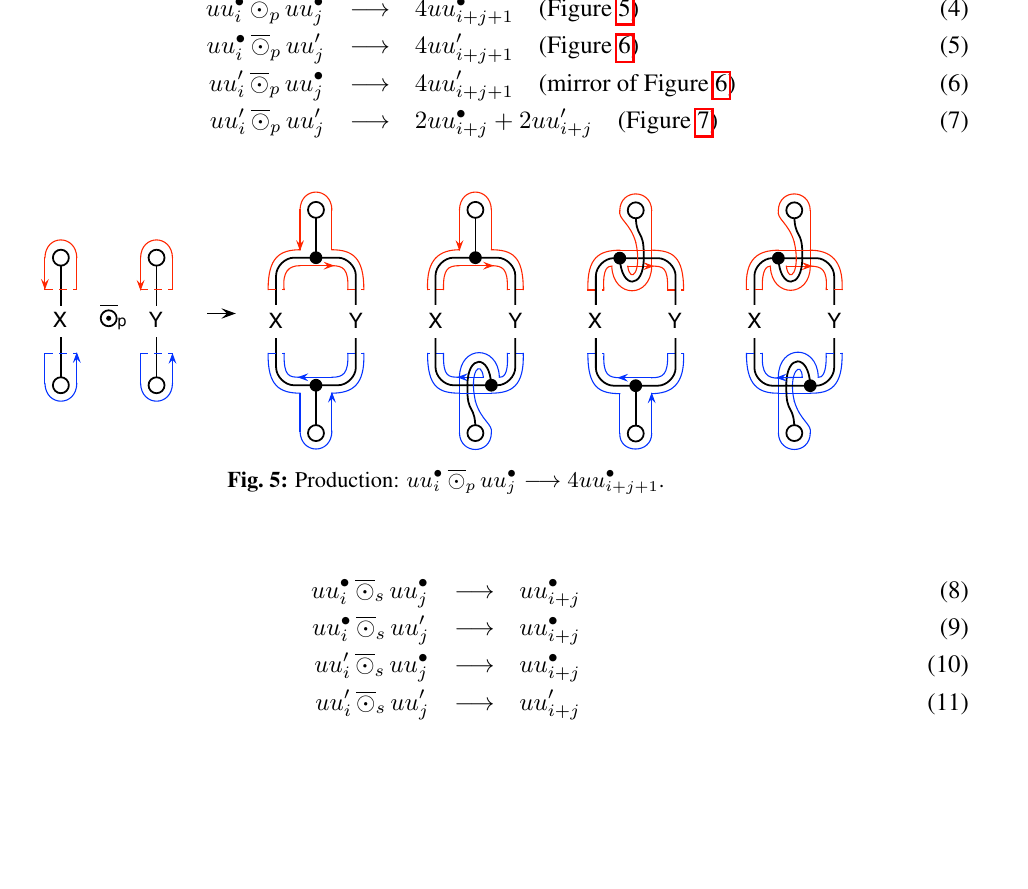
Fig. 5: Production: uu • i (cid:12) p uu • j −→ 4 uu • i + j +1